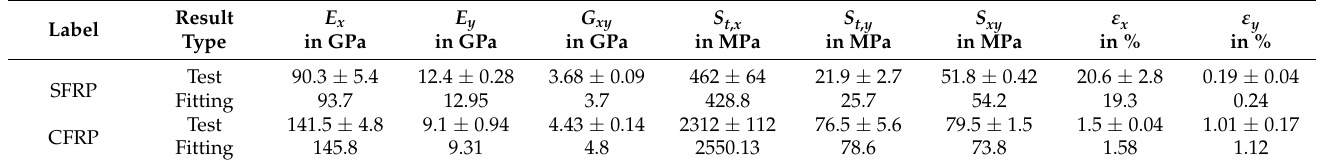
Figure 5. Experimentally determined stress–strain behavior and the result of parameter fitting for tensile tests of CFRP and SFRP in parallel to the fiber direction (CFRP_UD_L, SFRP_UD_L) ( a ), transverse to the fiber direction (CFRP_UD_T, SFRP_UD_T) ( b ) and for shear tests (CFRP_UD_S,SFRP_UD_S) ( c ). Table 3. Experimentally determined and numerically predicted mechanical properties of CFRP and